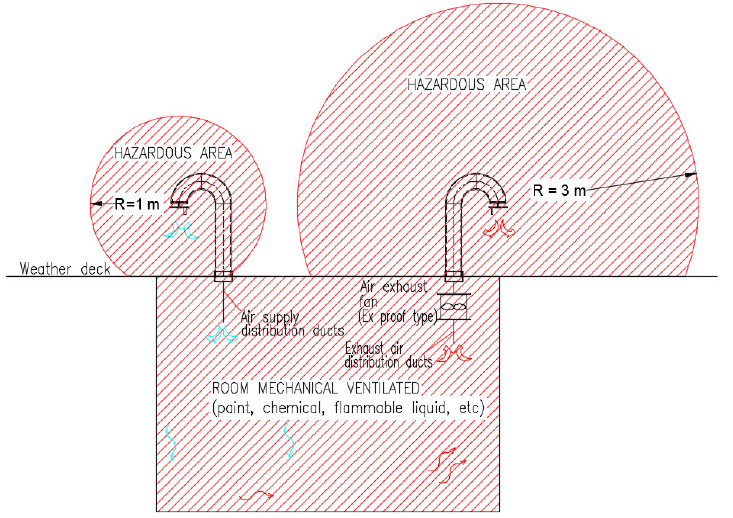
Figure 10. Typical arrangement. Ventilation of pain store, chemical store, another flammable liquid store, and oxygen-acetylene storage rooms, with extended hazardous areas.